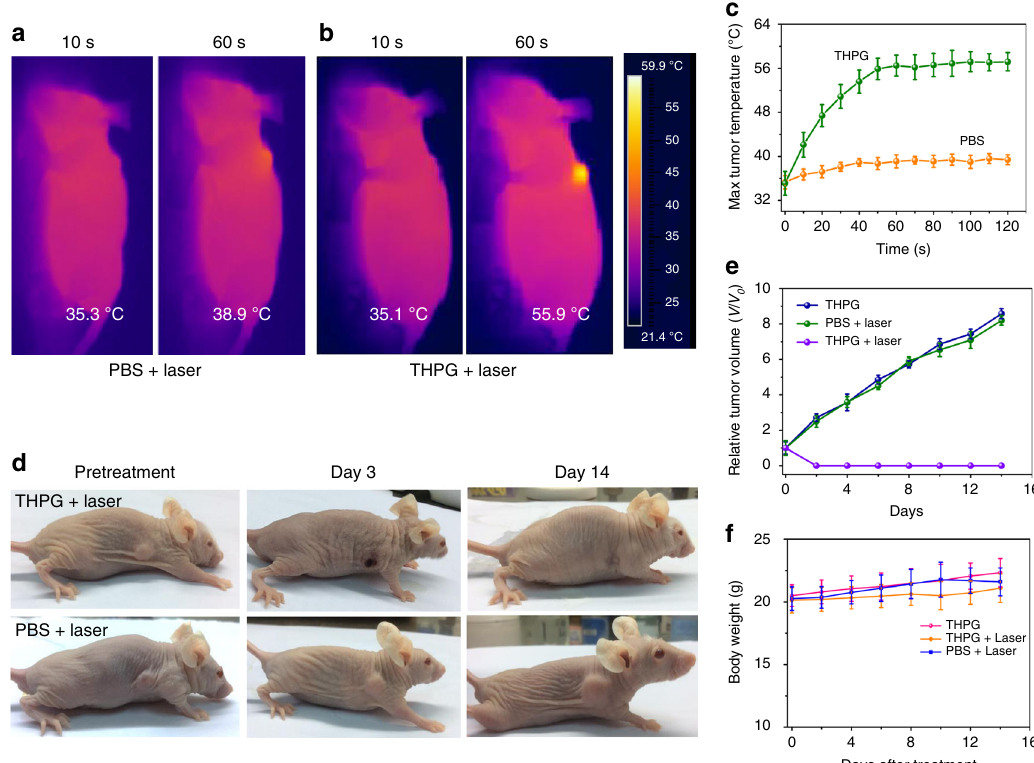
Fig. 7 In vivo evaluation of photothermal effect of THPG vesicle. Thermal images of MCF-7 tumor-bearing mice after injection with PBS ( a ) and THPG solutions ( b ) and irradiated under 635 nm laser at 200 mW cm − 2 for 10 min. c Quantitative analysis of temperature changes in tumor area during laser irradiation monitored by the thermal camera ( n = 5 biologically independent experiments. d Representative photographs of mice after PTT treatments. e Tumor growth inhibition pro fi les of different groups of tumor-bearing MCF-7 mice after treatments. ( n = 5 biologically independent mice). f Body weight curves of MCF-7 tumor-bearing mice upon different treatments ( n = 3 biologically independent mice). Data are presented as mean values + / − S.D.